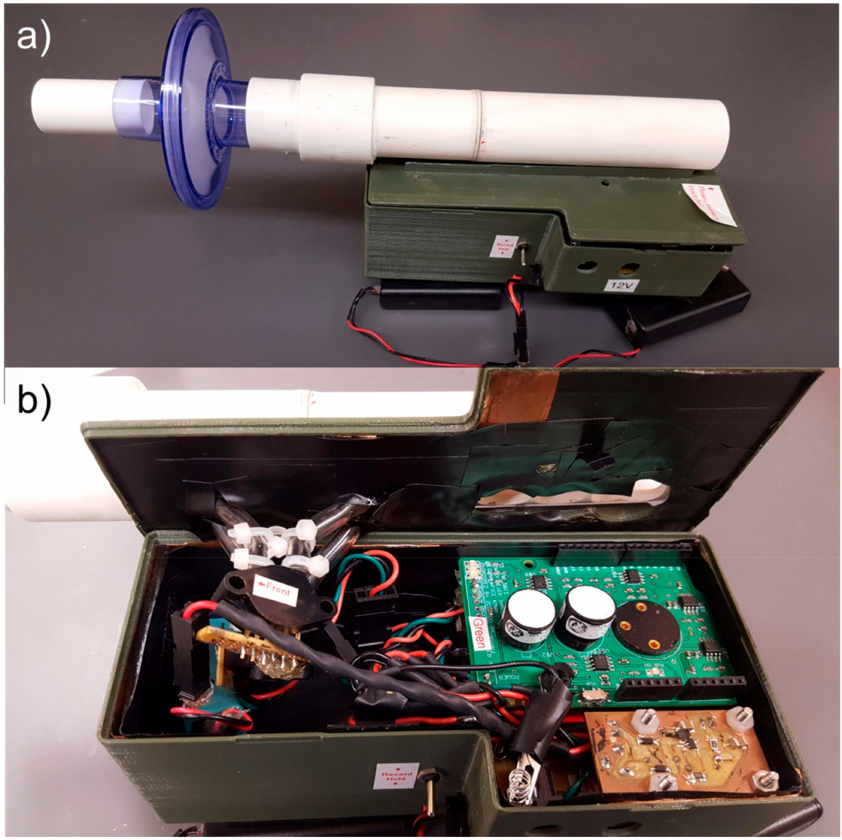
Figure 1. An open access platform is provided for a portable reconfigurable pulmonary lung function measurement system. It interfaces with common commercial android-based personal mobile devices for seamless real-time data monitoring and data telemetry. Commercial microcontrollers and custom printed circuit boards (PCBs) provide a modular approach to the platform design. Additional sensors can be integrated into this device over time. ( a ) Enclosed device. ( b ) Device interior with stacked PCBs and flow